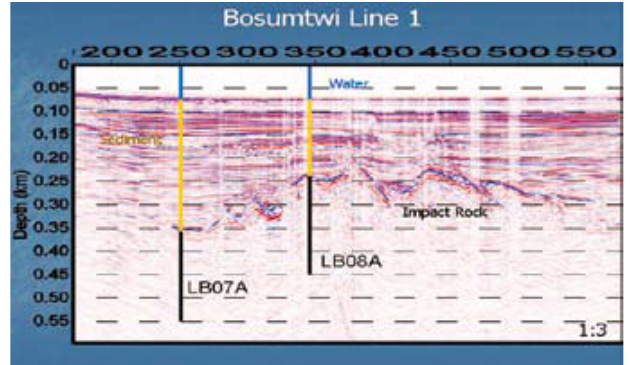
Figure 5. Seismic section (Scholz et al., 2002) with deep